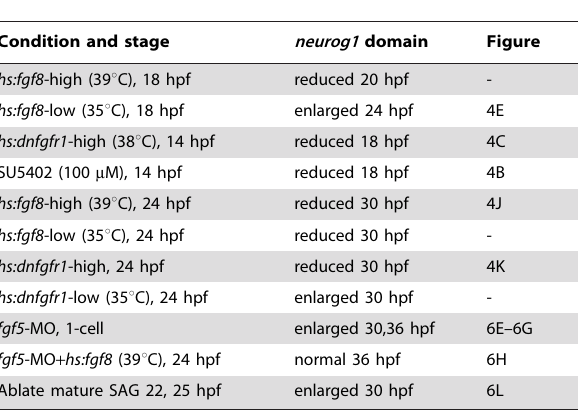
Table 1. Effects of altering Fgf on neuroblast specification.